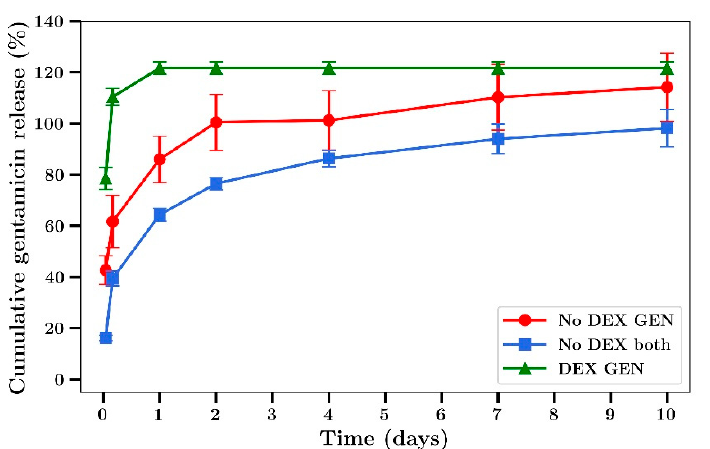
Figure 5. Time course of gentamicin release from Palacos bone cement films. Cement loaded with or without dextran T70 18% w/w ) and gentamicin. (Silver loaded at 0.8% and gentamicin at 0.8% w/w ) No DEX both refers to cement with gentamicin and Ag and no dextran ( n = 4). Gentamicin release from bone cement films in the absence of dextran containing either gentamicin alone or gentamicin combined with silver (Figure 7) was similar to the profiles obtained in experiments where dextran was included, whereby burst release was observed over 2 days with a low level of release after that with 100% release achieved at 10